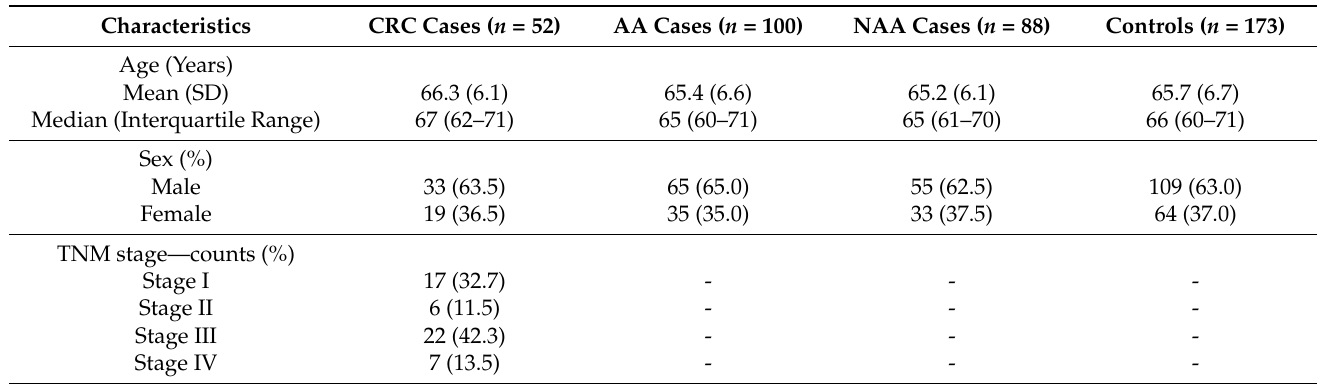
Table 1. Characteristics of the Study Population.